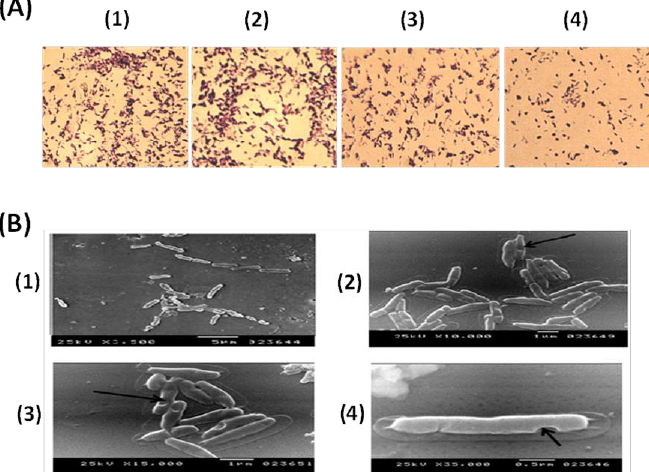
Figure 3. Microscopical examination of PAGs. ( A ) Light microscope pictures following crystal violet simple staining using oil immersion lens (×100): ( 1 ) P. aeruginosa untreated cells , ( 2 ) cells after the basic step, ( 3 ) cells after the H 2 O 2 step, and ( 4 ) P. aeruginosa ghost after the ethanol step. External structure integrity is observed in all smears. ( B ) Scanning electron micrographs at different magnification powers. ( 1 ) Normal P. aeruginosa cells showing intact cell walls. ( 2 ), ( 3 ), and ( 4 ) show BGs after chemical treatment showing a 3D non-deformed cell wall where the arrows show the pores formed.